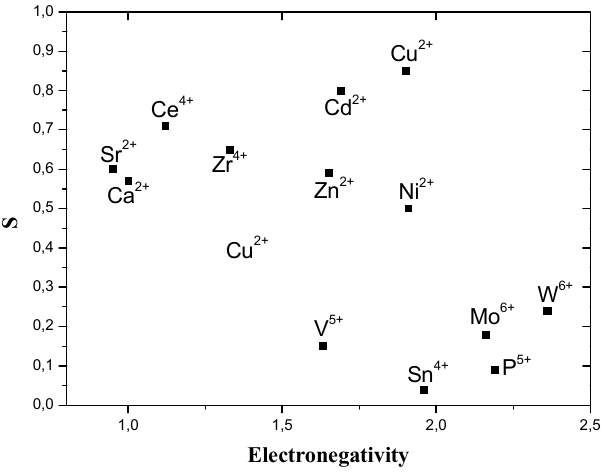
element to 50 ppm at 200 o C as a 2